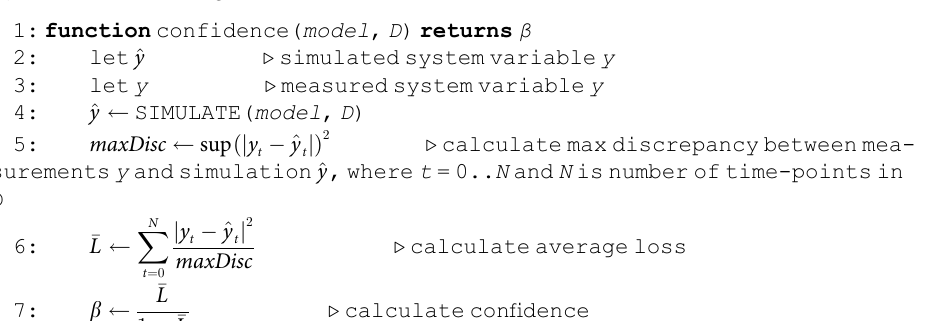
Algorithm 2 Calculating